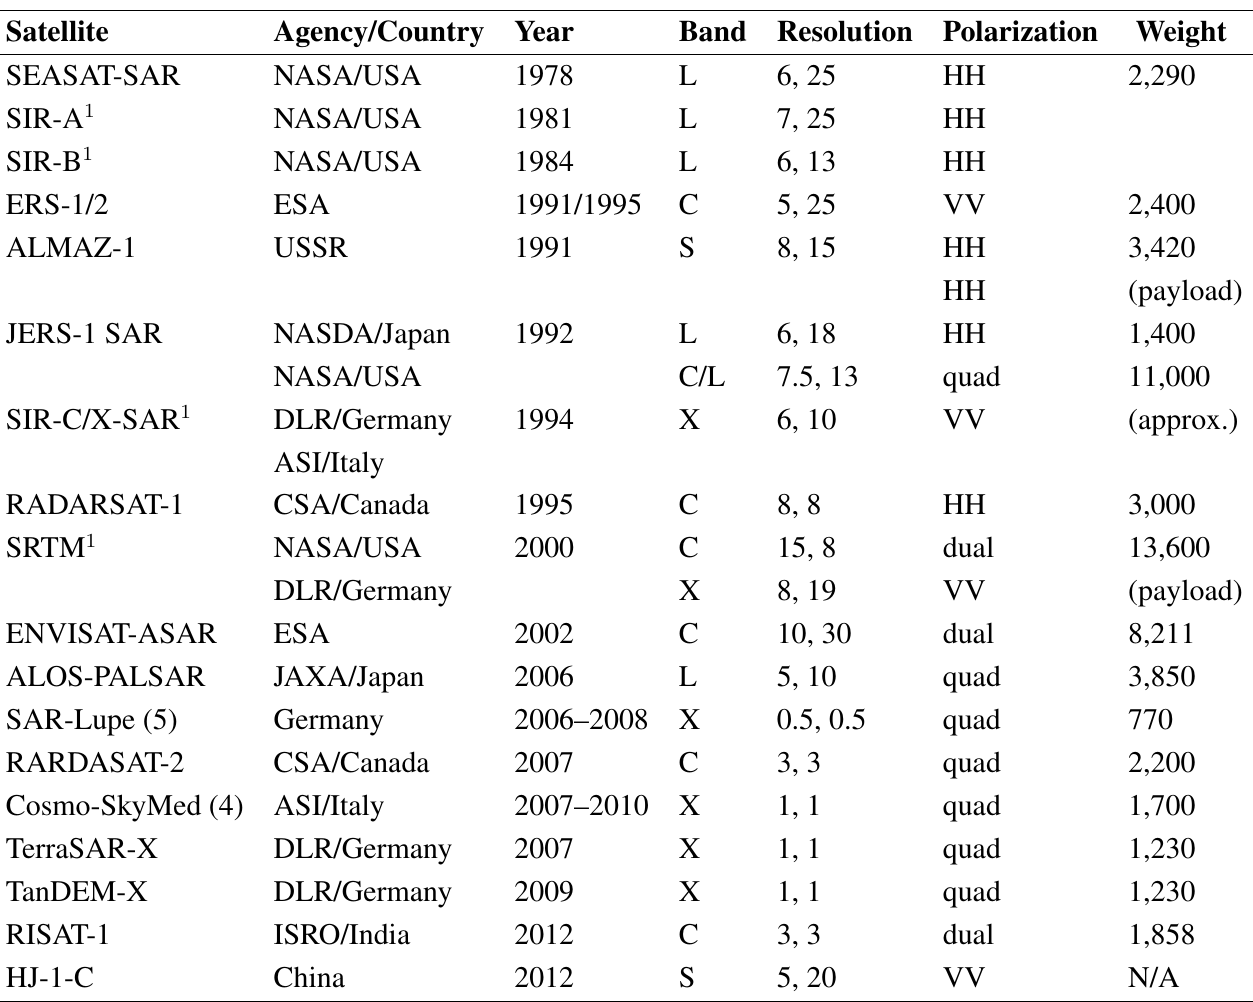
Table 2. Selected spaceborne and Shuttle-borne SARs for Earth observation. from SEASAT to ALOS completed their missions (by November 2012). Resolution is